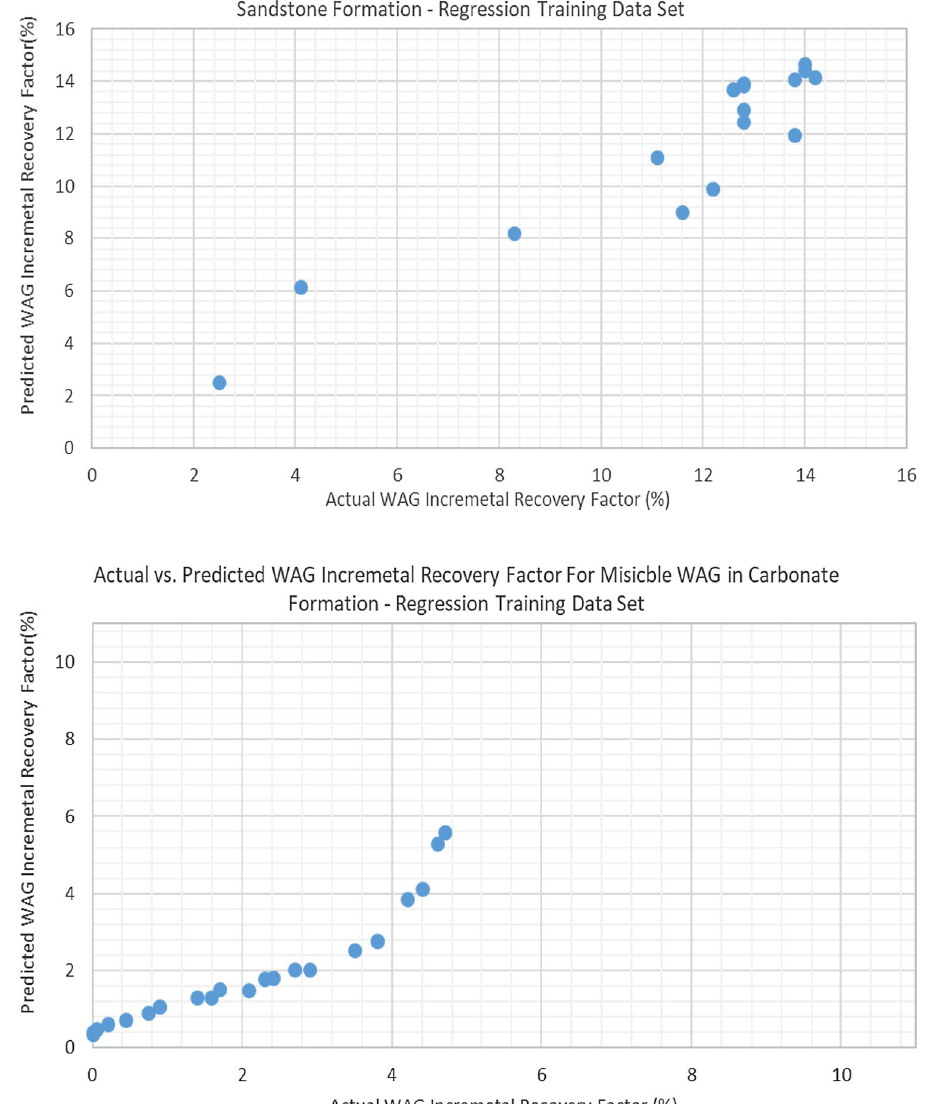
Fig. 7 Regression WAG incre- mental recovery factor predic- tion model training results for immiscible WAG in sandstone formation